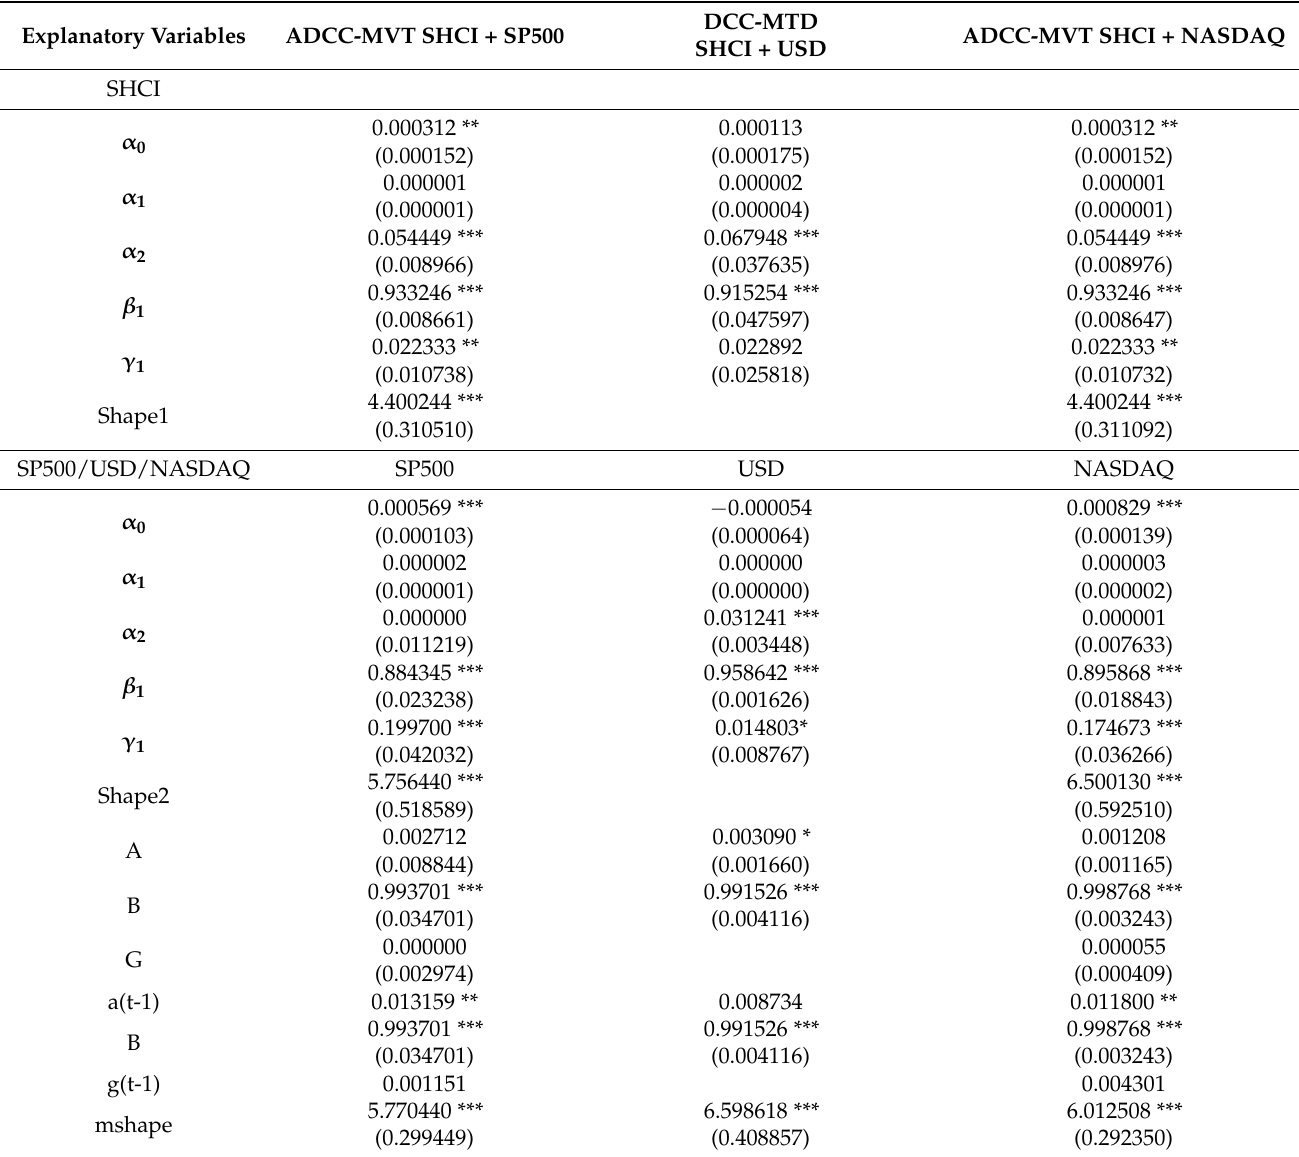
Table 5. The estimated results of the best fit